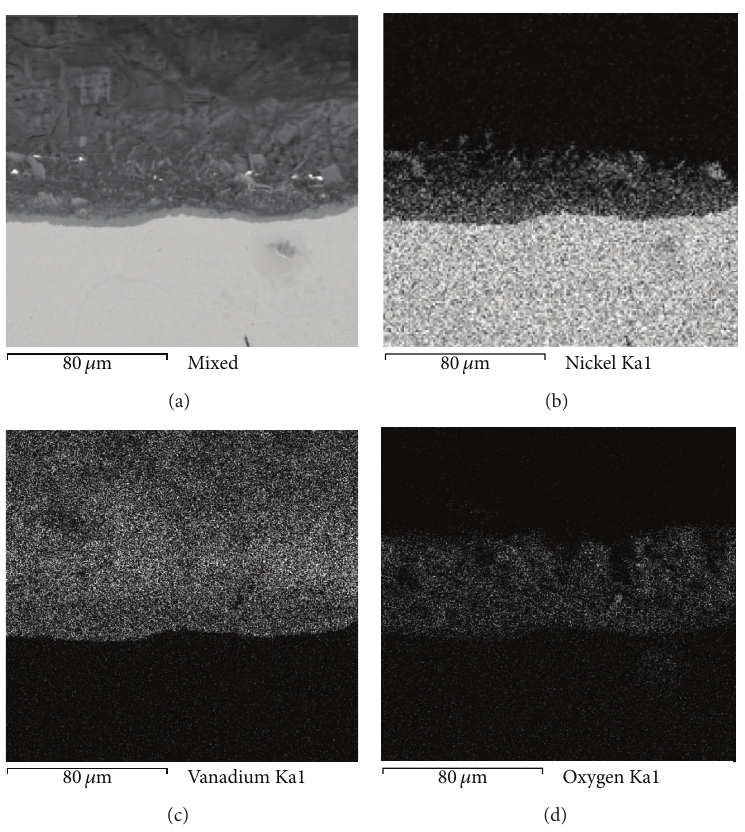
Figure 6: Cross-sectional aspect of Ni and elements distribution after corrosion test.